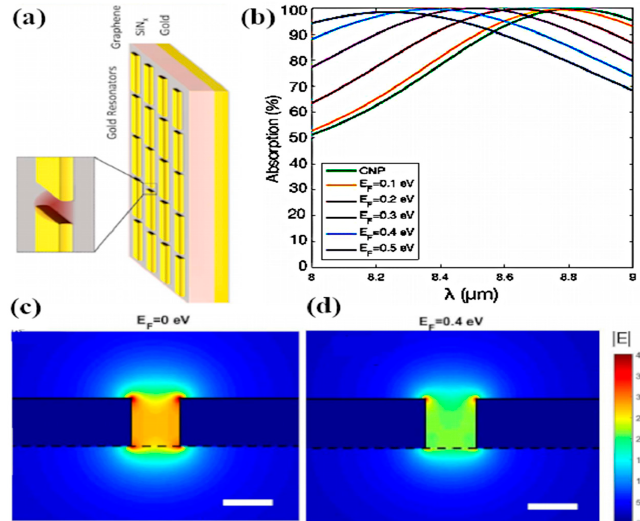
Figure 13. ( a ) Geometry of graphene–gold resonators, with graphene sandwiched between a silicon nitride substrate and gold nanoresonators; ( b ) Tunability of absorption at various Fermi energy levels; ( c ) EM field confinement at E F = 0 eV at the gap between the adjacent gold resonators; ( d ) EM field concentration at E F = 0.4 eV showing the detuning of resonance at different wavelengths. Copyright © 2017 American Chemical Society. Reprinted with permission from [143].